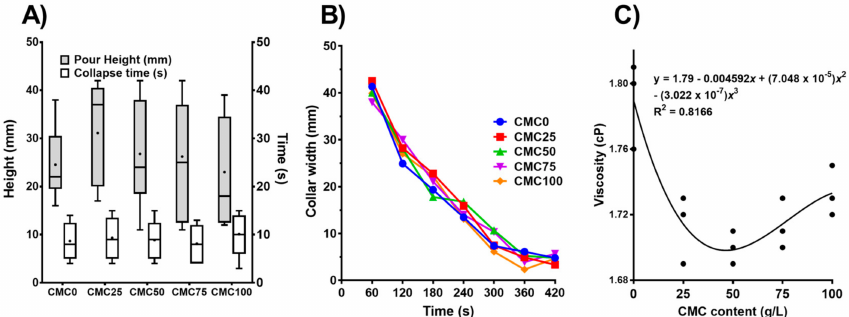
Figure 2. ( A ) Foam measurements by the free pour method. Effect of CMC addition on maximum foam height (pour height), and time until foam collapsed after pouring (collapse time). ( n = 3 per treatment); ( B ) effect of CMC addition on the change in mean collar width over time ( n = 3 per treatment); and ( C ) third-order polynomial (cubic) curve describing the relationship between CMC addition and mean wine viscosity